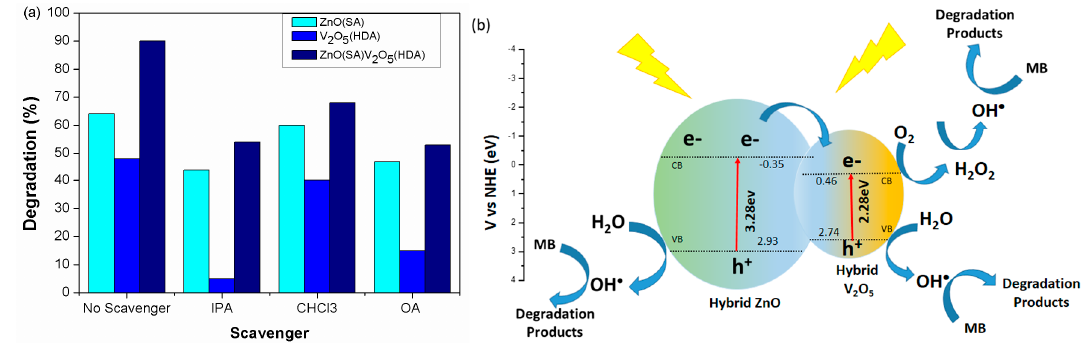
Figure 6. ( a ) Photocatalytic degradation of MB under visible light after addition of several trapping reagents ( b ) Possible mechanism of the photocatalytic activity of ZnO(SA)/V 2 O 5 (HDA) for degradation under visible light irradiation.